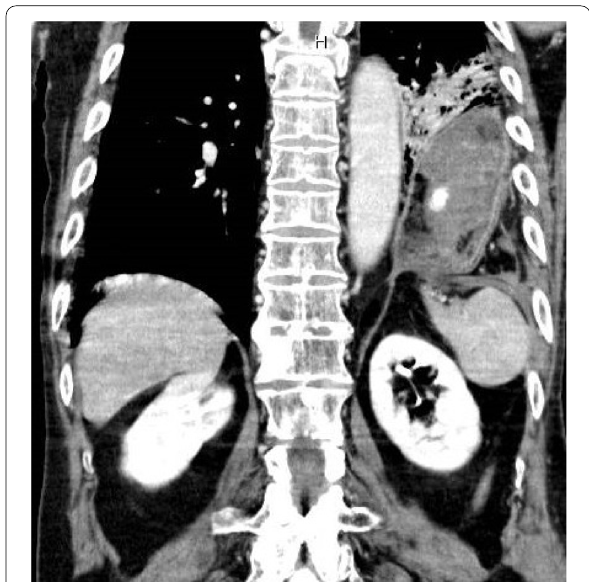
Fig. 1 Preoperative chest computed tomography scans showing left diaphragmatic injury with hernia